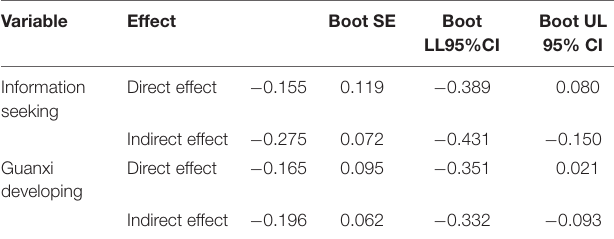
TABLE 4 | Psychological availability as mediator in the relationship between coworker ostracism and newcomers’ proactive